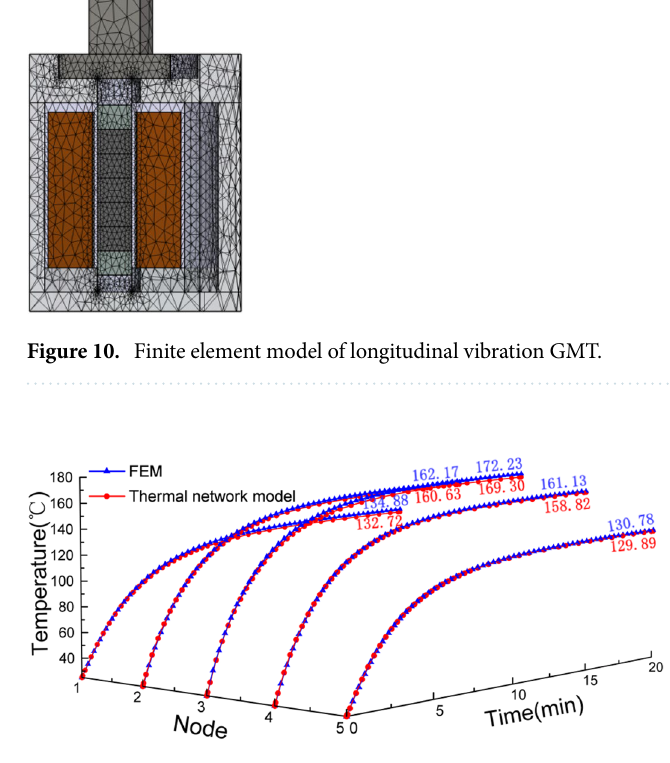
Figure 11. Comparison of the GMM rod temperature at different positions obtained from the FEM simulation and the TETN model.